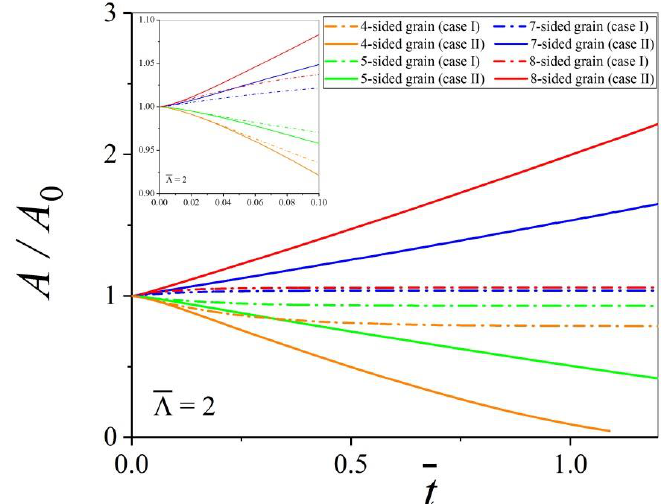
Figure 14. Evolution of the grain boundaries and the triple junction for the symmetry unit of an initially regular octagon with Λ = 2. ( a ) Case I, ( b ) Case II.